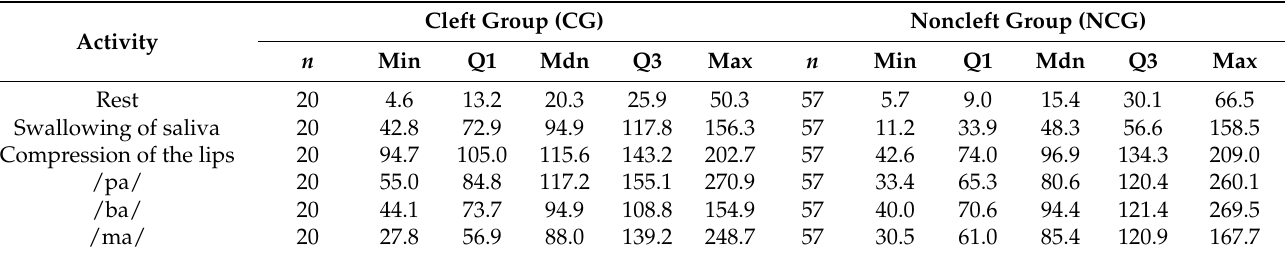
Table 3. Electrical activity of the upper lip [ µ V/ µ V%] in the children examined in the study. Activity